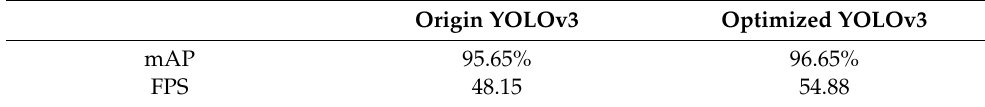
Table 5. mAP and FPS comparison before and after reducing feature